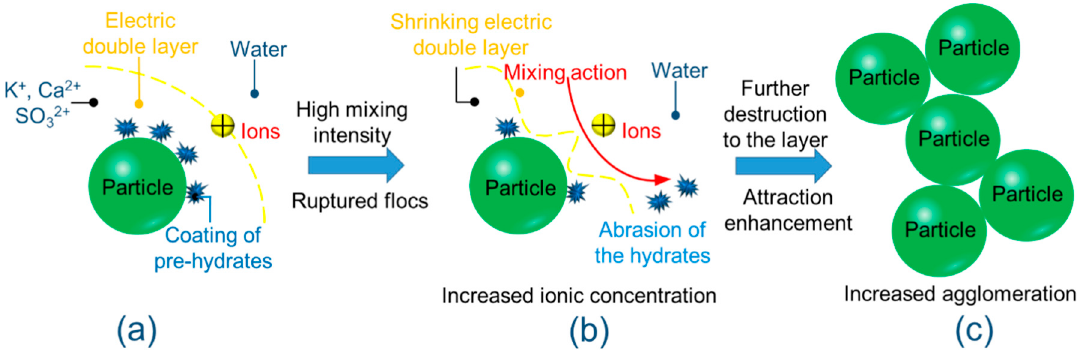
Figure 11. Schematic of the mechanism depicting how high-intensity mixing can lead to increased agglomeration. ( a ) Electric double layer of particle. ( b ) Shrinking electric double layer. ( c ) Particle aggregation.